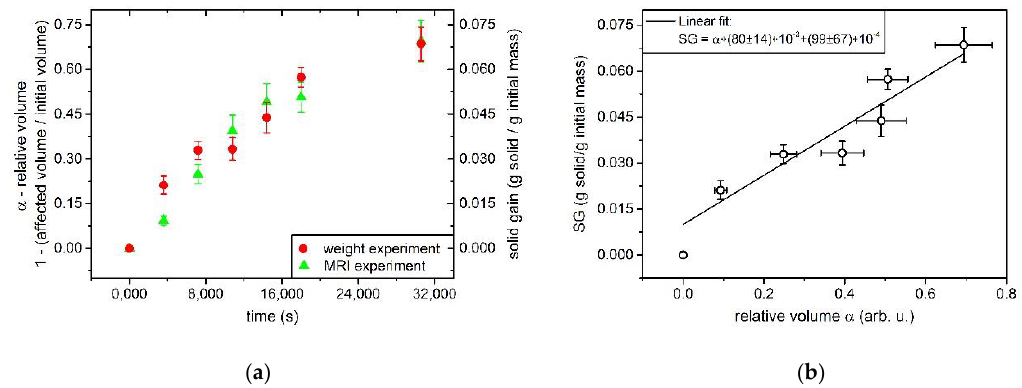
Figure 5. ( a ) Kinetics of solid gain (red circles) and relative volume (green triangles) during the osmotic dehydration of courgette in the CuSO 4 solution. ( b ) Correlation between the solid gain (SG) determined from the mass transport analysis and the relative volume ( α t ) obtained from the MRI data. Error bars represent standard uncertainty.